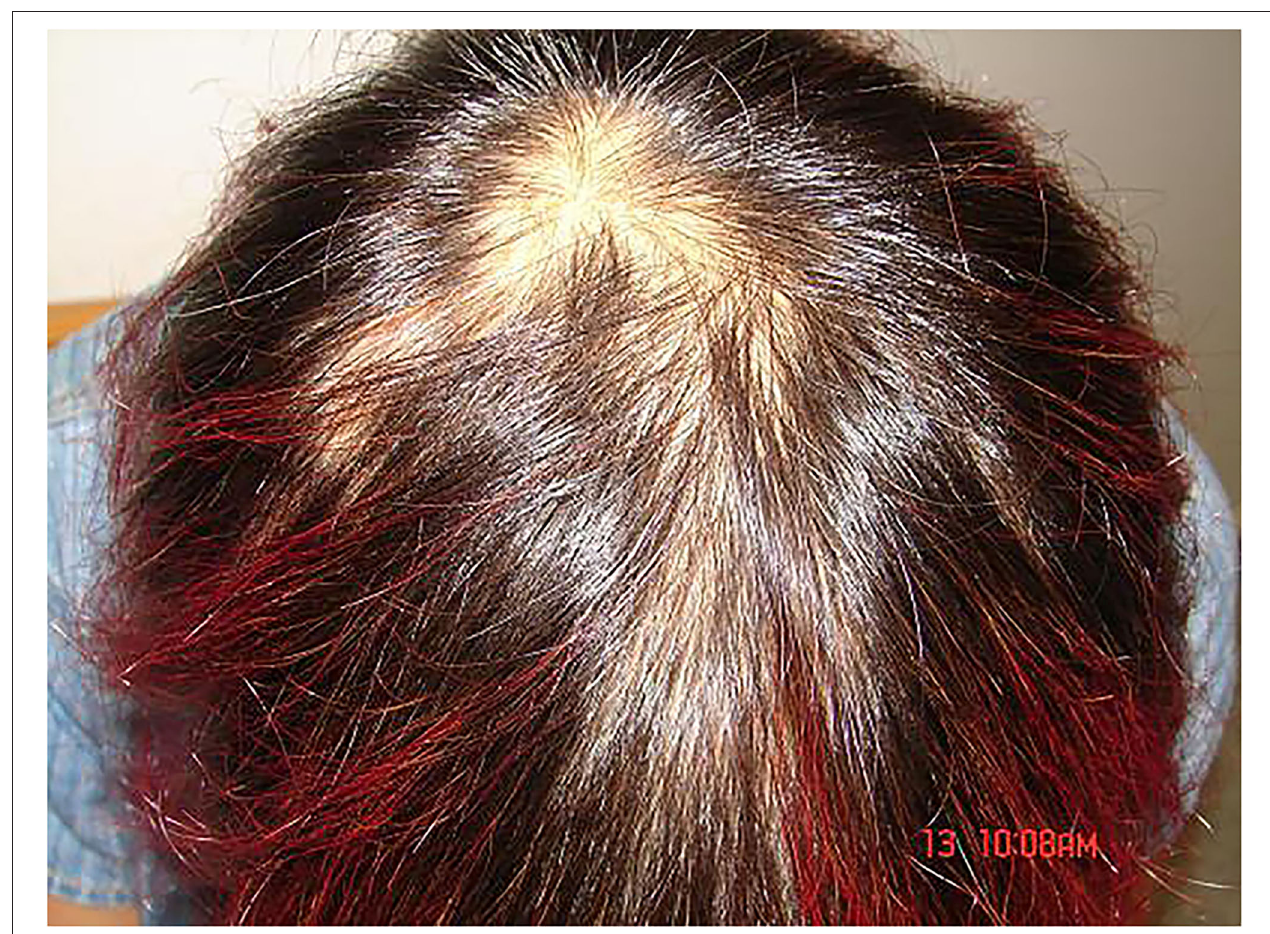
FIGURE 1 | With the head as the center, multiple areas of alopecia with irregular